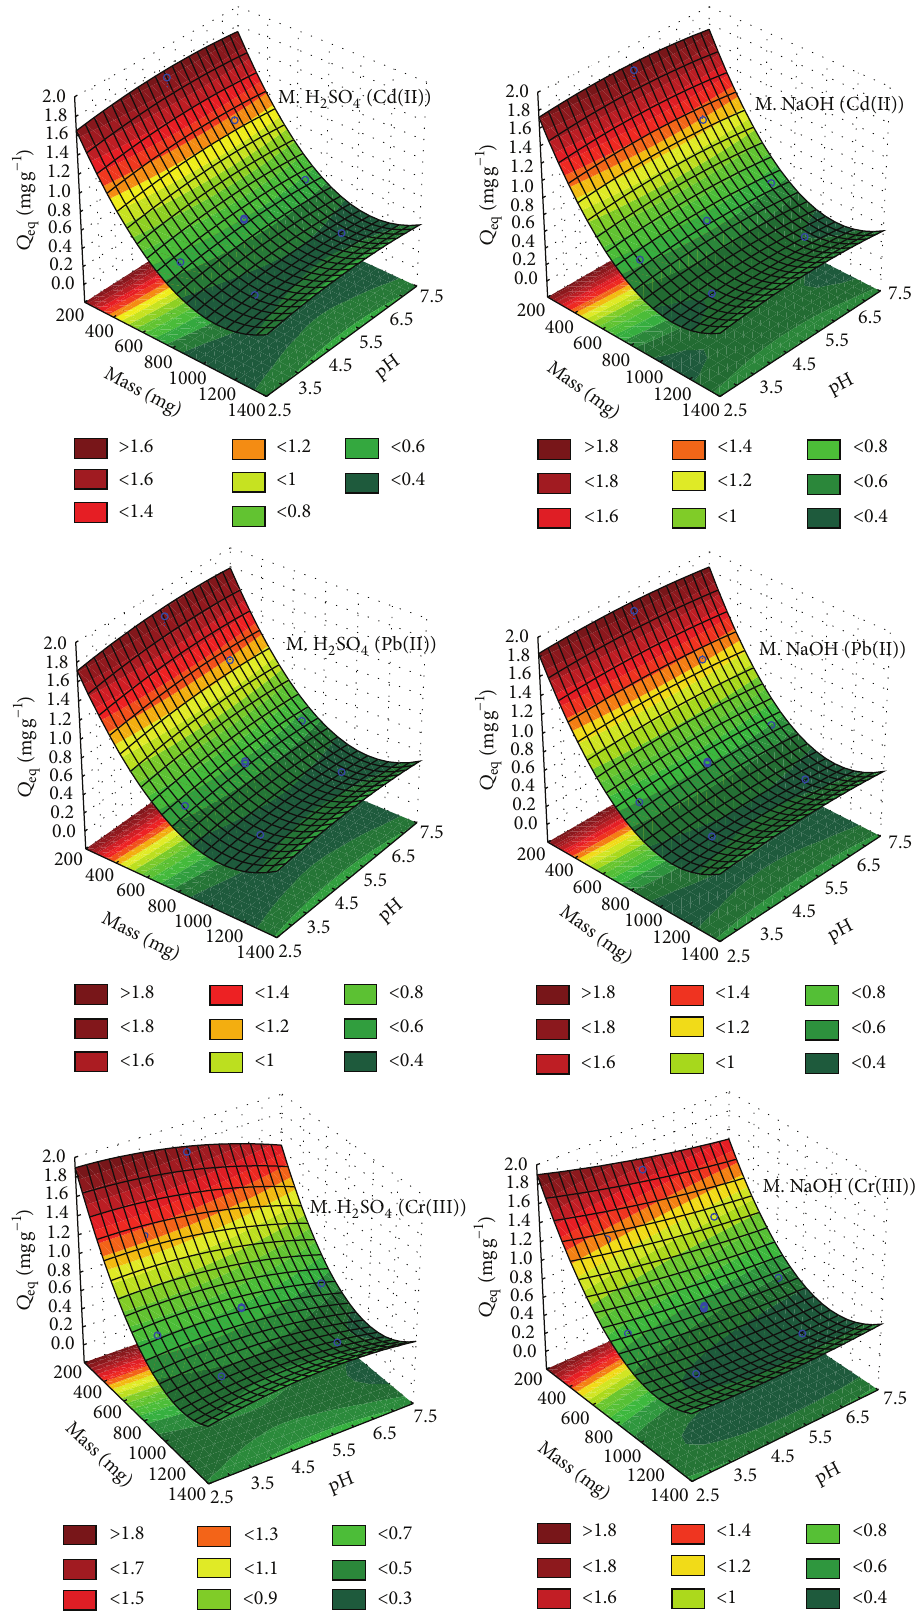
Figure 2: Graphs of response surfaces obtained in the adsorption of Cd(II), Pb(II), and Cr(III) by modified materials from cassava peels depending on adsorbent mass and pH of the mono-elementary